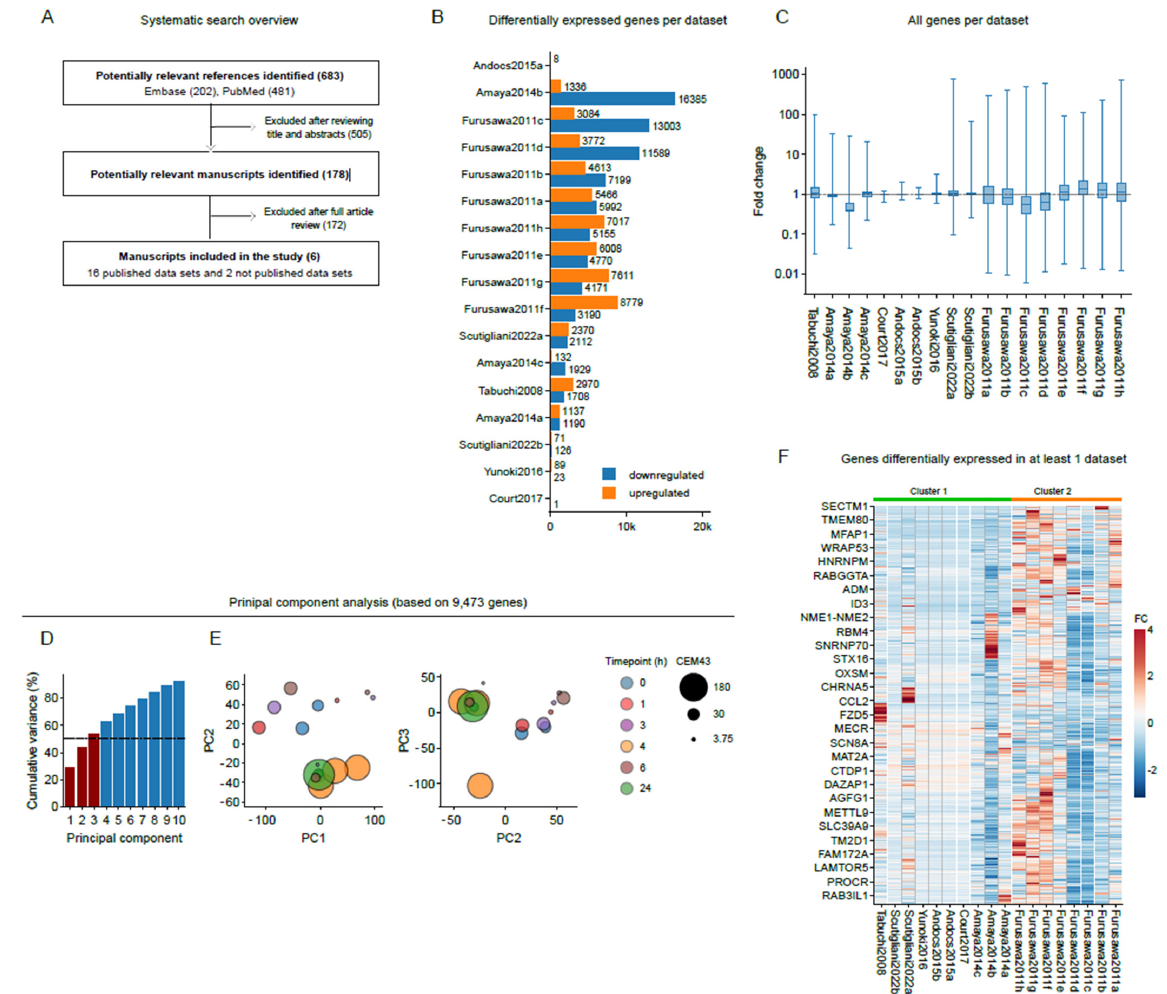
Figure 1. Hierarchical clustering and principal component analysis reveal similarities in gene expression patterns that are independent of experimental characteristics. ( A ) Flow chart displaying the systematic search and selection process for the meta-analysis. ( B ) Number of differentially expressed genes (1.5 − 1 ≥ fold change ≥ 1.5) per study. ( C ) Fold change in gene expression per study. Genes that were shared among all studies were used in the principal component analysis. ( D ) Cumulative histogram of eigenvalues of principal components. The dotted horizontal line marks 50% of the cumulative variance. Principal components visualized in ( E ) are indicated in red. ( E ) Visualization of the principal component analysis. The time point after hyperthermia treatment in hours (h) and the thermal dose, calculated as cumulative equivalent minutes at 43 degrees Celsius (CEM43), are indicated. ( F ) Genes that are differentially expressed in at least one study. Fold change (FC) is centered and scaled per row.